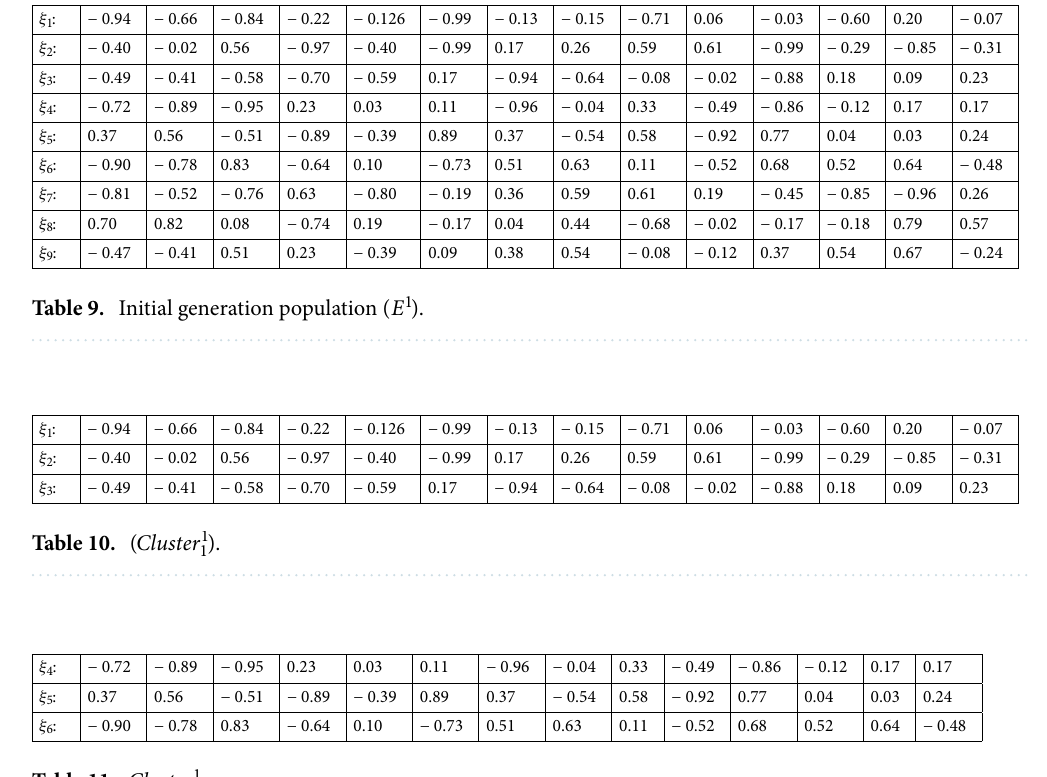
Table 11. Cluster